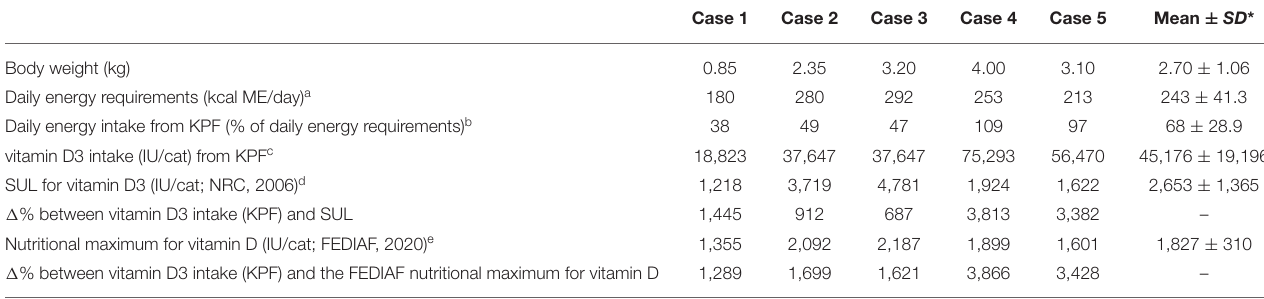
TABLE 3 | Daily energy and vitamin D3 intake from kitten pet food, safe upper limit for vitamin D3, nutritional maximum for vitamin D, and the percentage difference for each